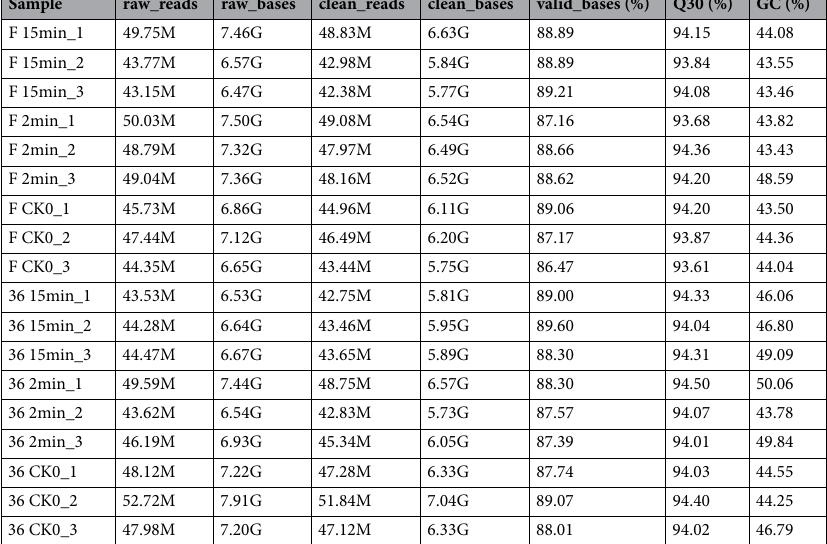
Table 1. Statistics of clean reads in the eggplant transcriptomes.